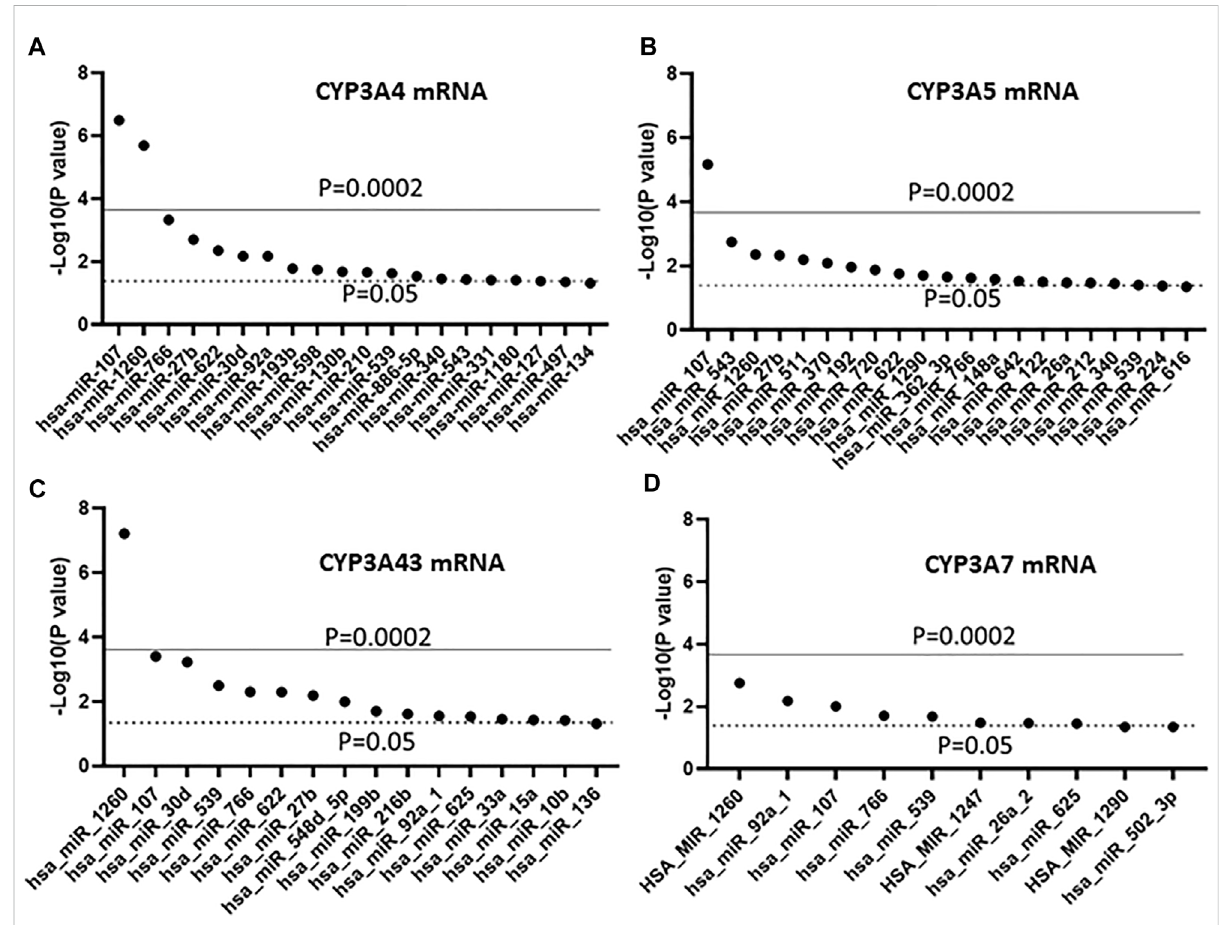
FIGURE 2 AssociationbetweenmiRNAsandmRNAexpressionoffour CYP3A genesinhumanliversamples. (A) CYP3A4; (B) CYP3A5; (C) CYP3A43and (D) CYP3A7. miRNAs were measured using The TaqMan OpenArray Human MicroRNA panels. Linear regression was used to test the association between the 247 measured miRNAs and mRNA expression of the four CYP3As. Only miRNAs with an association p ≤ 0.05 are